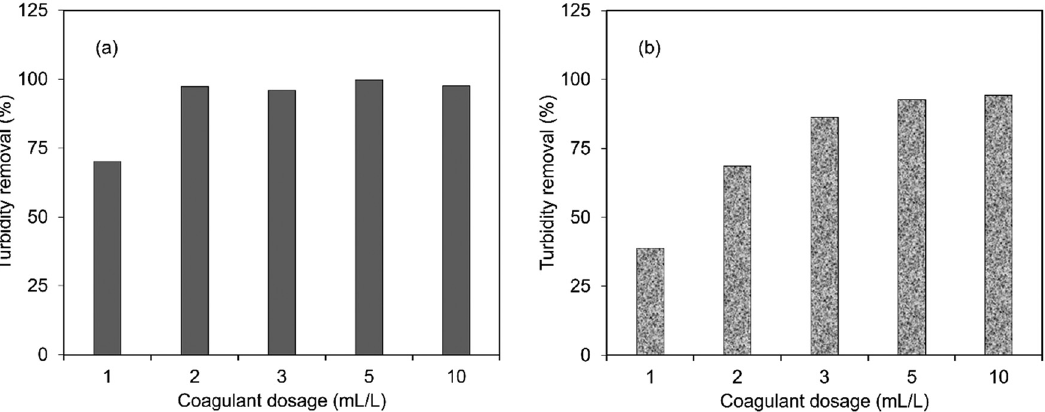
Figure 4: E ff ect of natural coagulant dosage on the removal of turbidity. Natural coagulants were L. leucocephala ( a ) and S. grandi fl ora ( b )